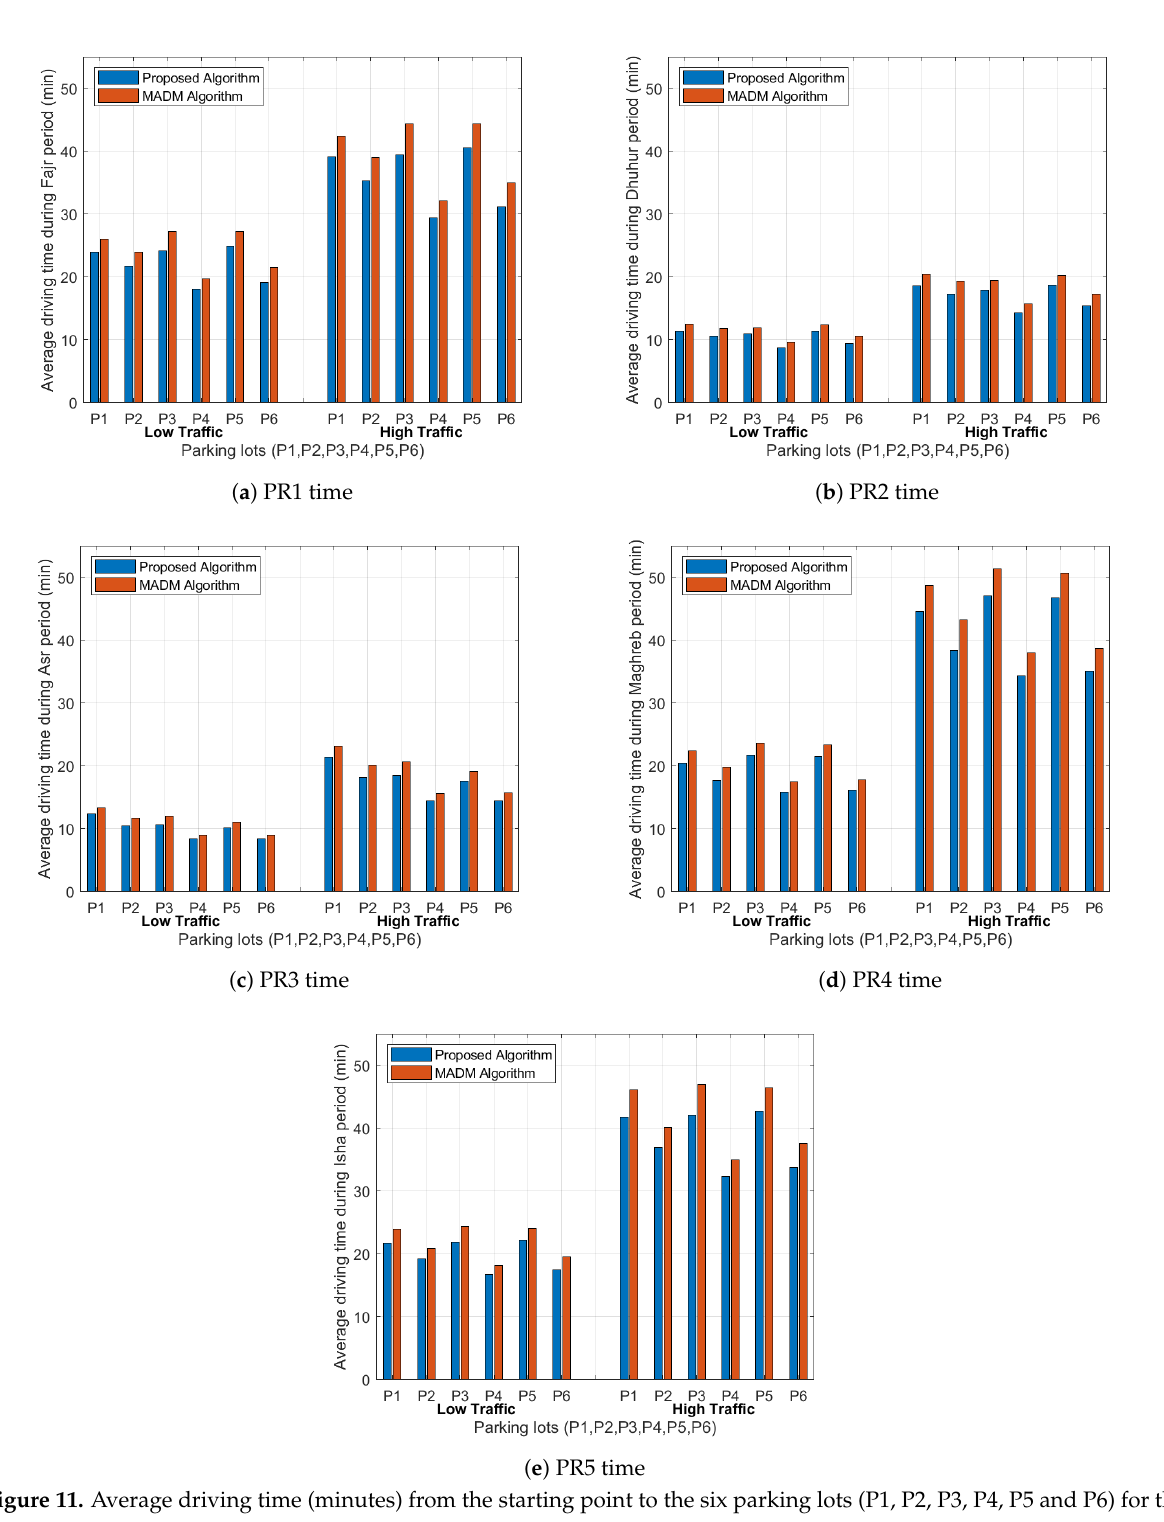
Figure 11. Average driving time (minutes) from the starting point to the six parking lots (P1, P2, P3, P4, P5 and P6) for the five time periods (PR1–PR5) for both algorithms under low and high traffic